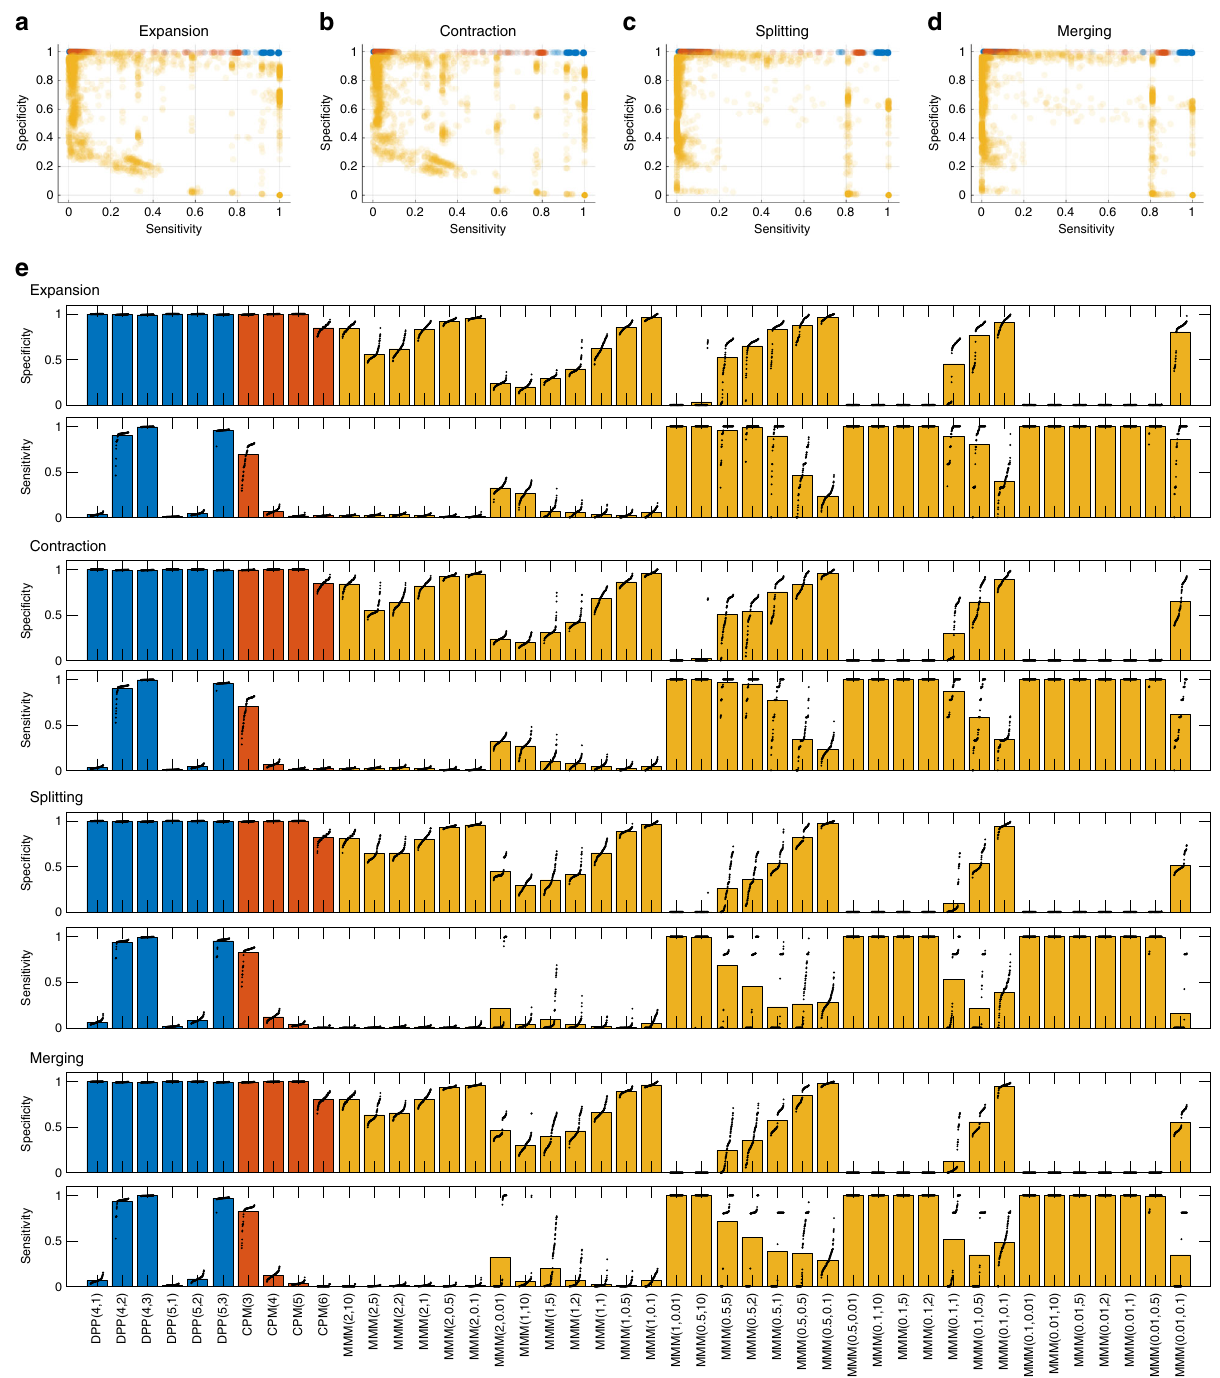
Fig. 4 DPPM performs with higher sensitivity and speci fi city than two existing methods in the four simulation scenarios. Speci fi city and sensitivity of DPPM (blue), CPM (red), and MMM (yellow) for n = 100 independent simulations with different noise instantiations of each dynamic community evolution scenario. a Community expansion, b Community contraction, c Community splitting, and d Community merging. Each circle indicates the result of one simulation with one parameter con fi guration (see “ Methods ” ). e Summary results for each community tracking method applied to each simulation scenarios. Bars indicate the mean sensitivity and speci fi city for each parameter con fi guration of each method. Dots indicate the results of the n = 100 simulations for each simulation scenario and